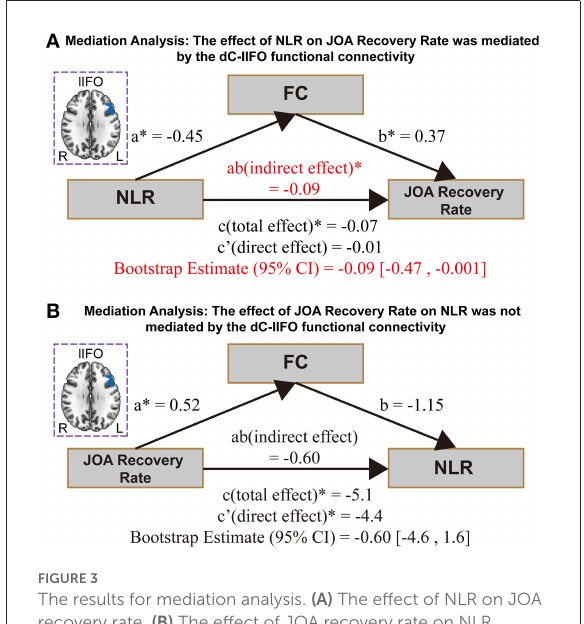
FIGURE3 The results for mediation analysis. (A) The effect of NLR on JOA recovery rate. (B) The effect of JOA recovery rate on NLR. NEU/LYMPH, neutrophils/lymphocyte ratio; JOA, Japanese Orthopedic Association; dC, dorsal caudate; IFO, inferior frontal